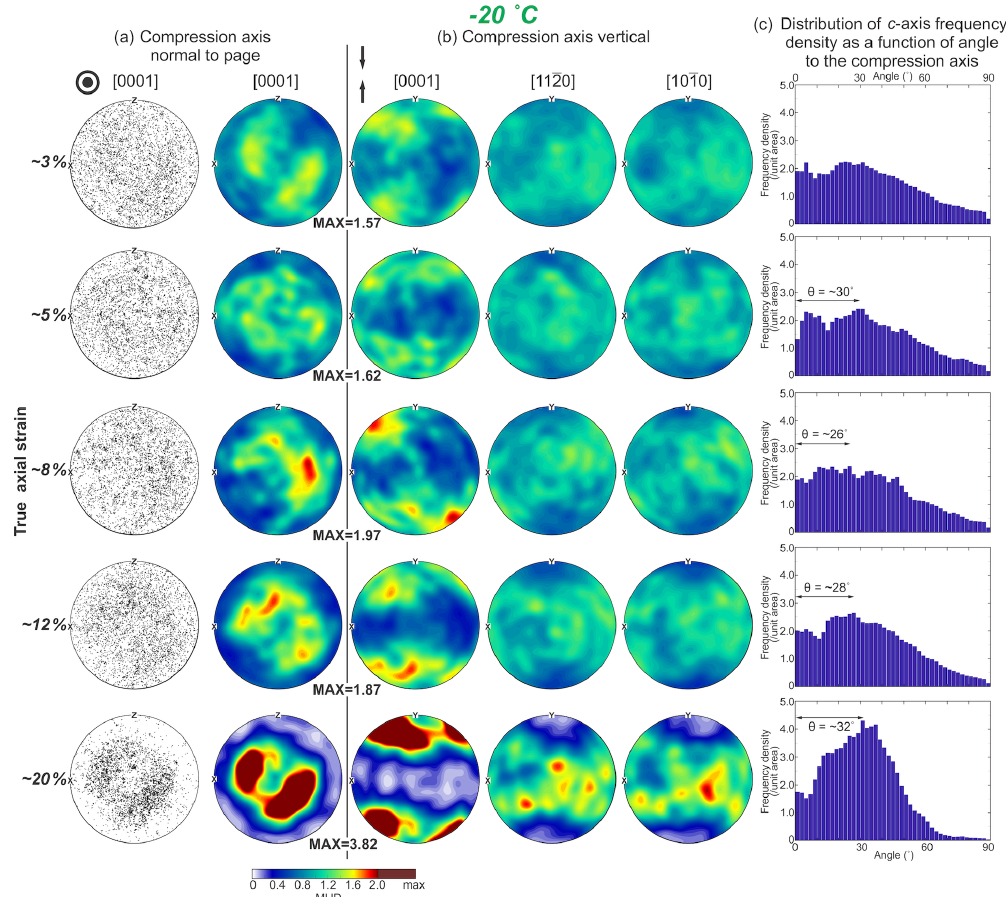
Figure 9. Crystallographic preferred orientations (CPOs) from EBSD data with 30µm step size for ice samples deformed at − 20 ◦ C. Expla- nation of annotations and the descriptions of sections (a) to (c) are the same as in Fig.